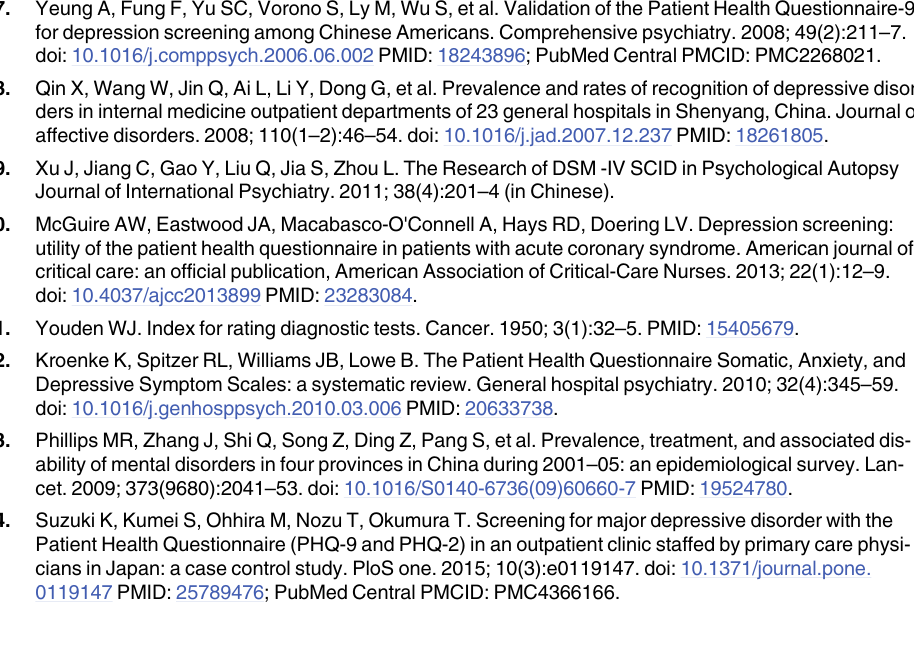
PLOS ONE | DOI:10.1371/journal.pone.0151042 March 15,